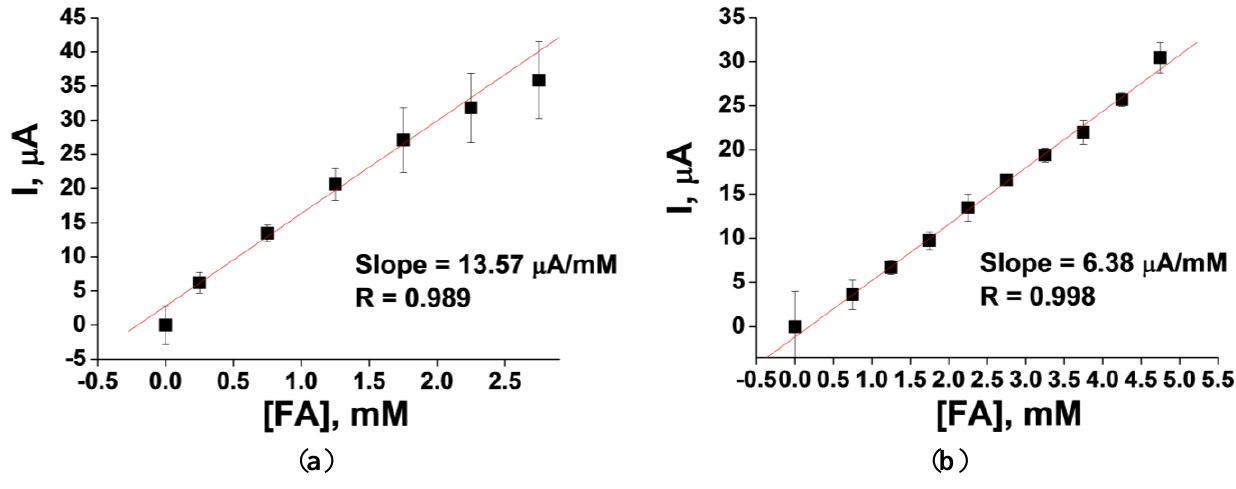
Figure 3. ( a ) Linearity test for the amperometric response of the 3.05 mm rod Pt-carbon electrode and 4 mm planar Pt-carbon electrode DRP-150 to FA; ( b ) Conditions: working potential 0 mV vs. Ag/AgCl, 20 mM PB, pH 7.5. Slopes of the lines (as sensitivity characteristics) and R (linear regression coefficients) are shown in the